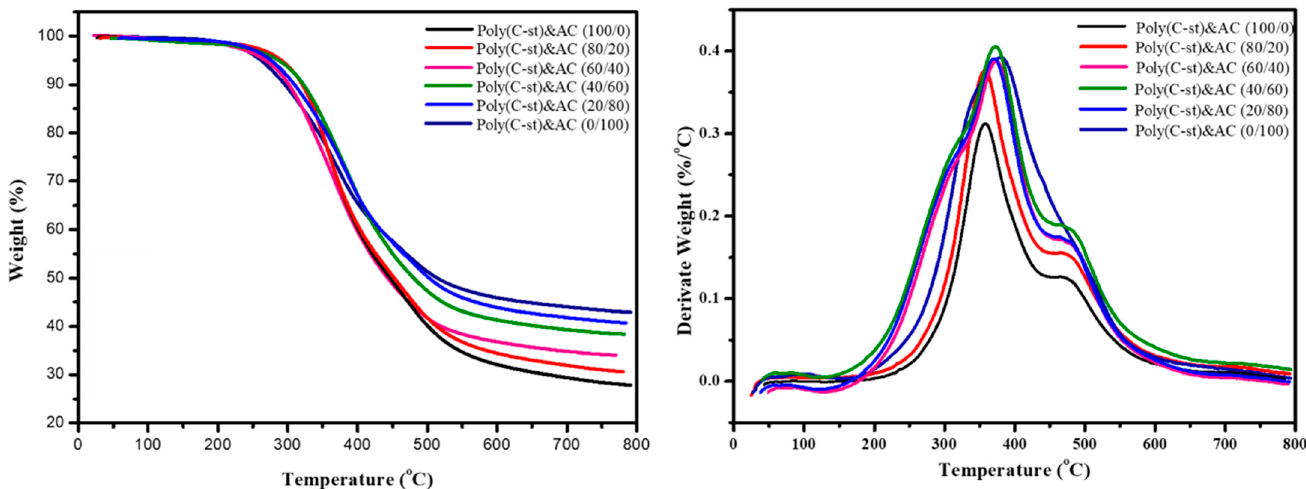
Figure 6. TGA thermograms of poly(C ‐ st)/AC films. Table 4. Data obtained from TGA thermograms.